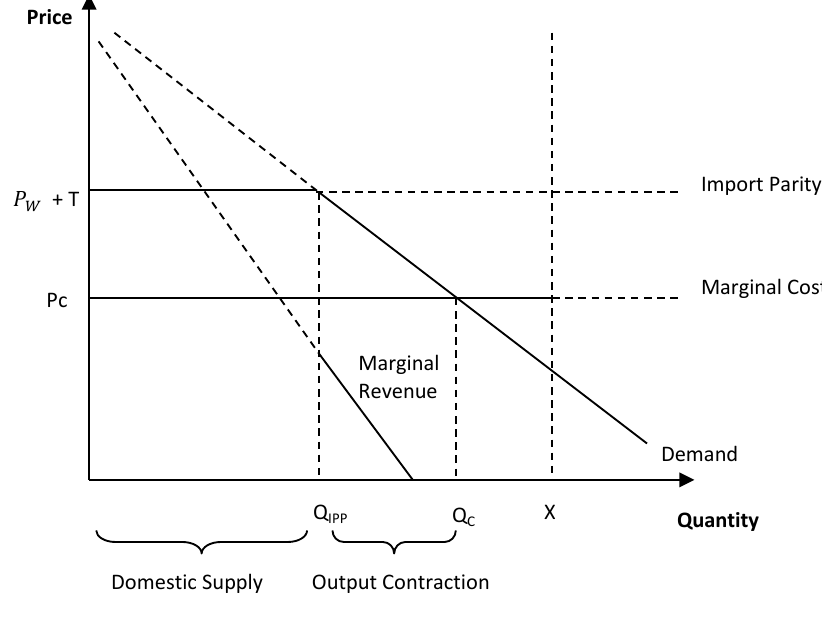
FIGURE 4: IPP with excess capacity and domestic monopoly